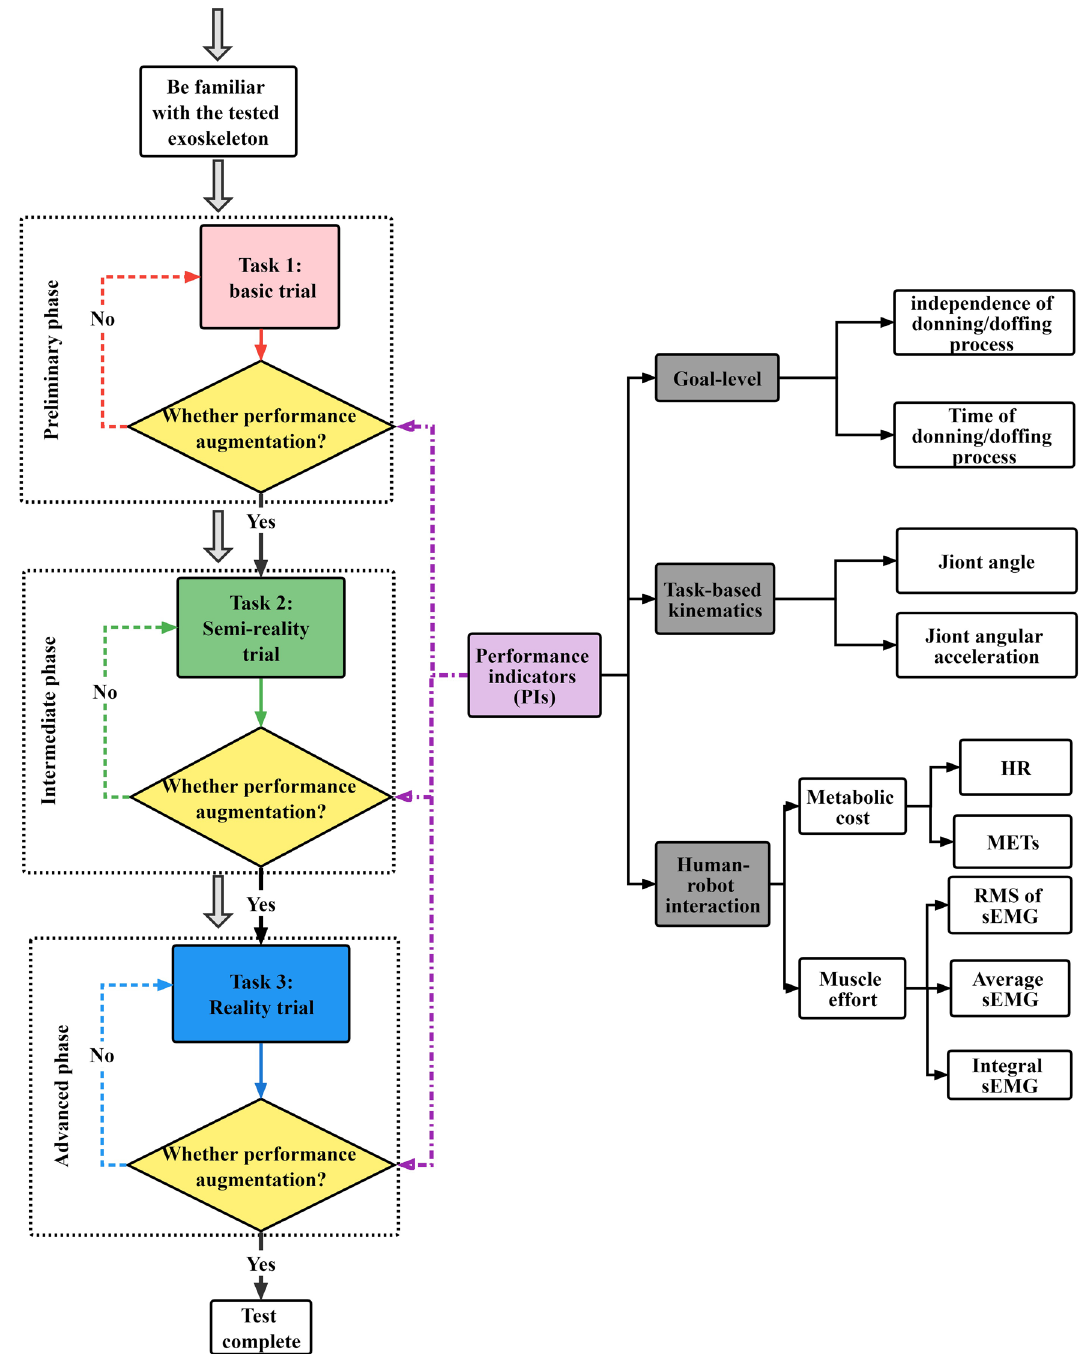
Figure 1. Flow diagram of the IE approach to evaluate the overall exoskeleton performance. Three trial tasks at the preliminary, intermediate, and advanced phases are shown in the dashed box. PIs are divided into three aspects, which are shown in the gray filled